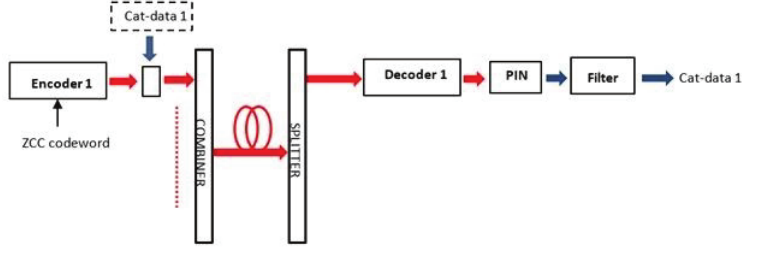
Fig. 2 Catenated-OFDM Optical CDMA based on ZCC